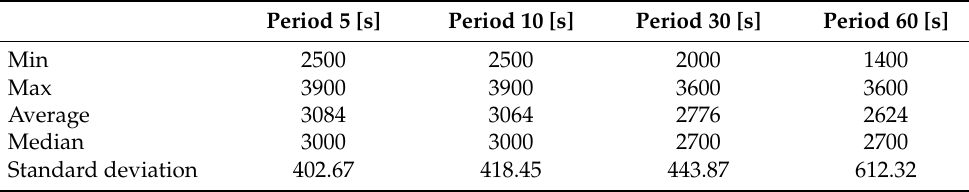
Table 5. Resulting distances [m] at the time of detection of two trains on two neighbouring edges. Period 5